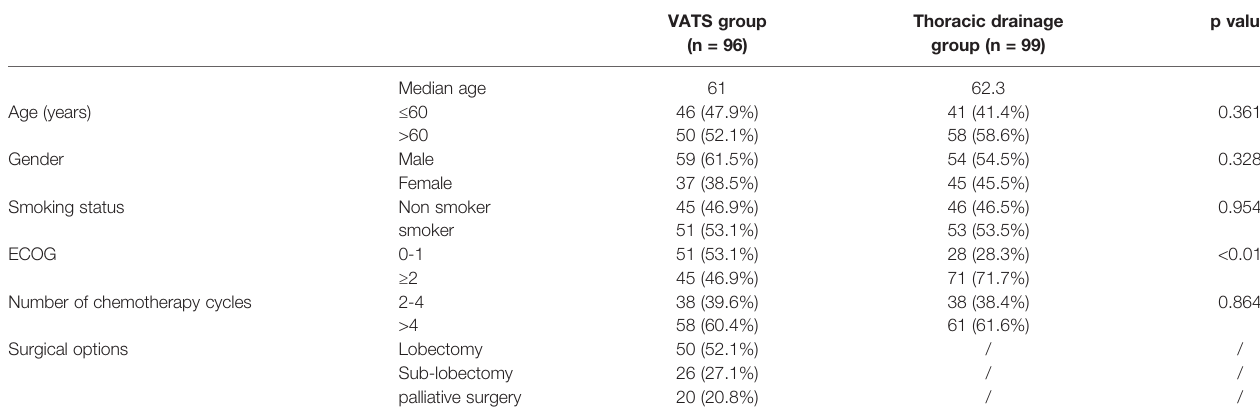
TABLE 1 | Baseline characteristics of all